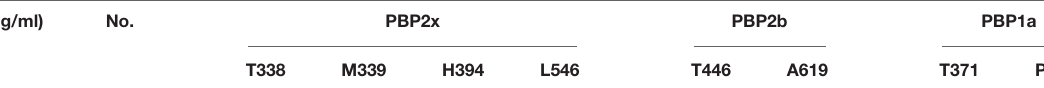
TABLE 4 | Association of serotypes, penicillin susceptibility and variations of conserved motifs forming or surrounding active penicillin-binding proteins (PBPs) binding sites in PBP2x, PBP2b, PBP1a among 300 S. pneumoniae isolates. Serotype MIC( µ